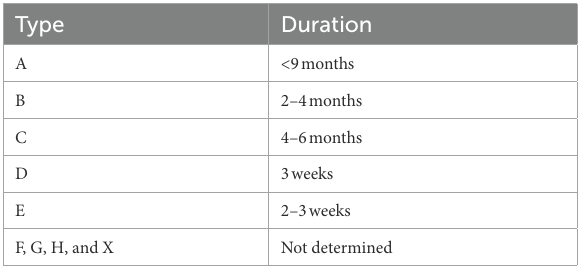
TABLE 2 Duration of the effect of different types of BoNT in mice (Pellett et al., 2015, 2018a,b; Gardner and Barbieri, 2018). Type